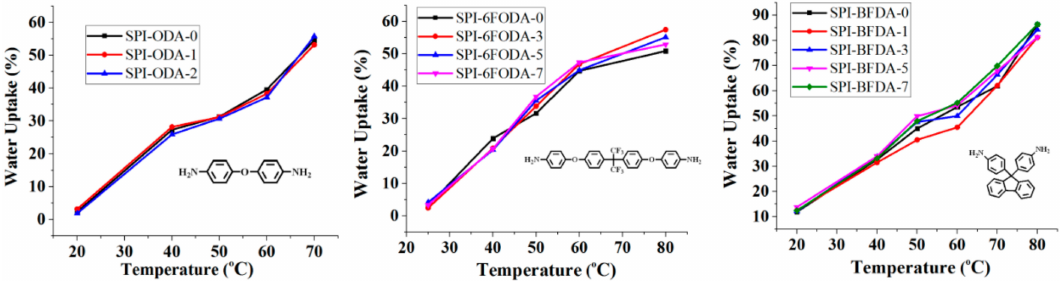
Figure 7. Water uptake of the three SPI based membranes.